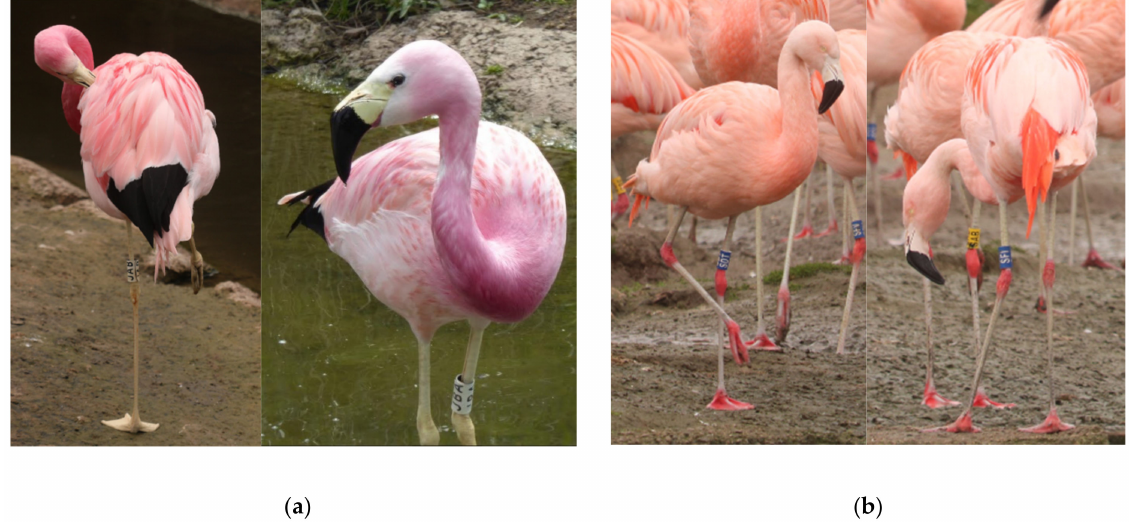
Figure 1. ( a ) Andean flamingo: Head, neck and upper breast are a deep mauve-pink, lower breast and back are paler pink mottled with red; wing-coverts are more heavily marked red. Flight feathers are black, more obvious than in other species, as not covered by back plumes. Legs are yellow; bill is black, pale yellow at base sometimes with pink flush on culmen; eyes are red-brown, with a small area of red skin on the lores. ( b ) Chilean flamingo: Plumage of head, neck and body is pale salmon pink, deeper on lower neck and upper breast. Scapulars, long back feathers, and upper and lower coverts are red. Legs are gray with contrasting red-pink feet and joints. Bills have an extensive black tip. The base of the bill is paler, almost white and the eyes are yellow. Morphological descriptions are taken from Brown and King (2005